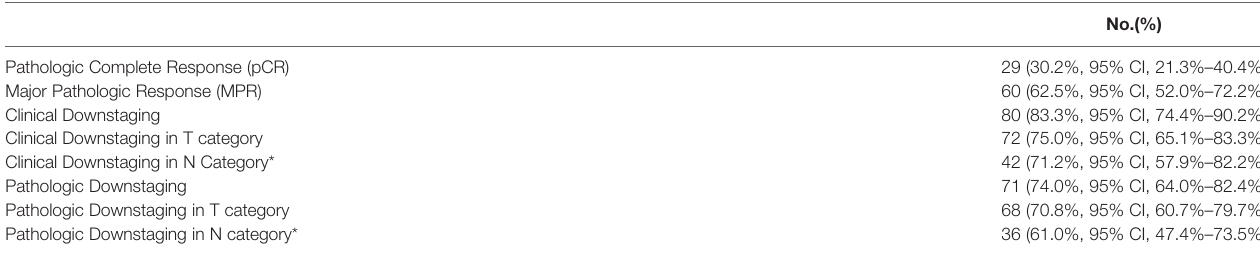
TABLE 2 | Response assessment.